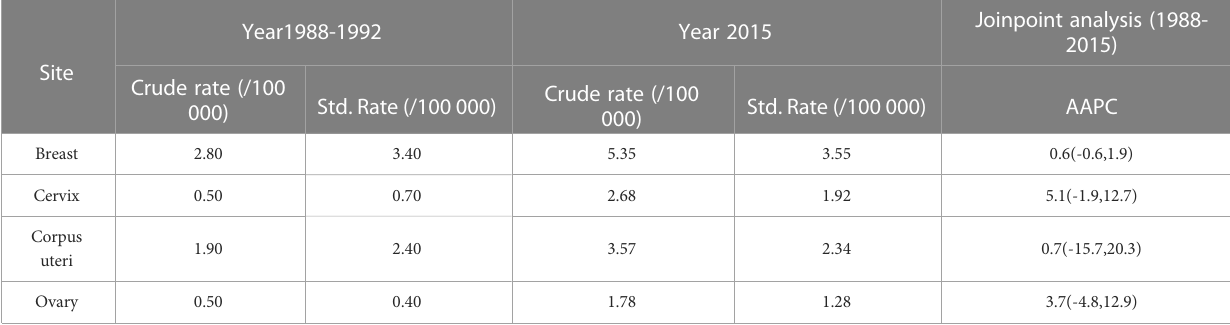
TABLE 2 Crude mortality rates, age standardized mortality and Joinpoint analyses for 1988 through 2015 in